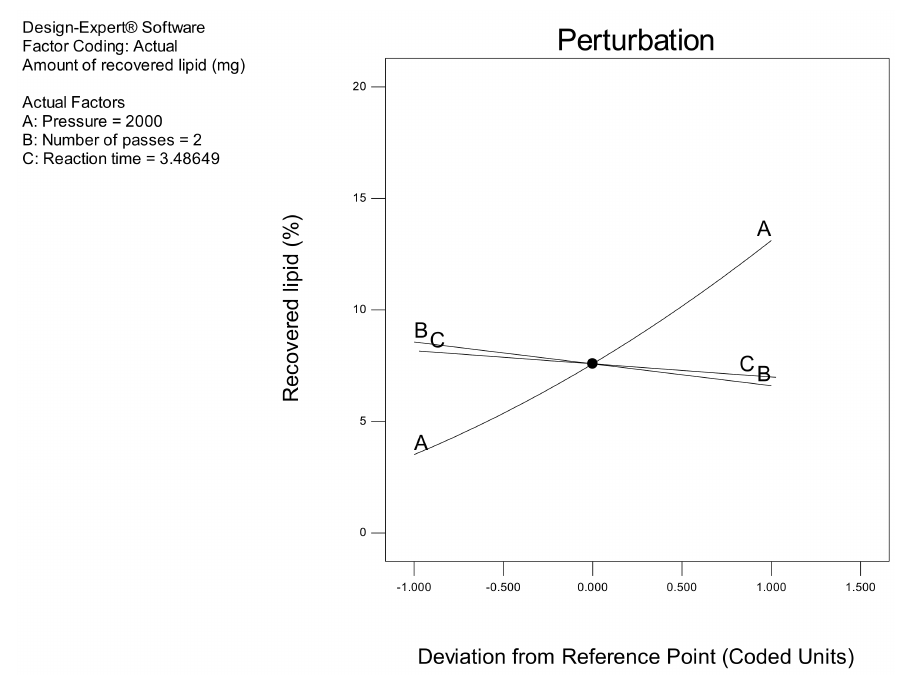
Figure 1. Perturbation plot for percentage of recovered